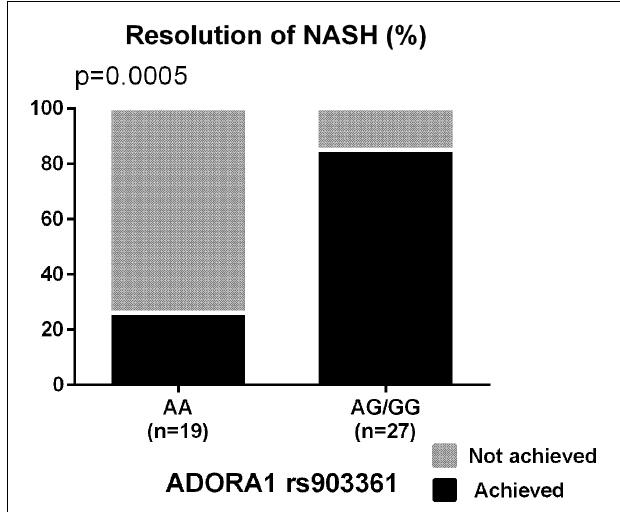
FIGURE 2 | Percentages of participants who achieved the resolution of NASH based on ADORA1 rs903361 genotype. P -values from Cochran Armitage trend tests are